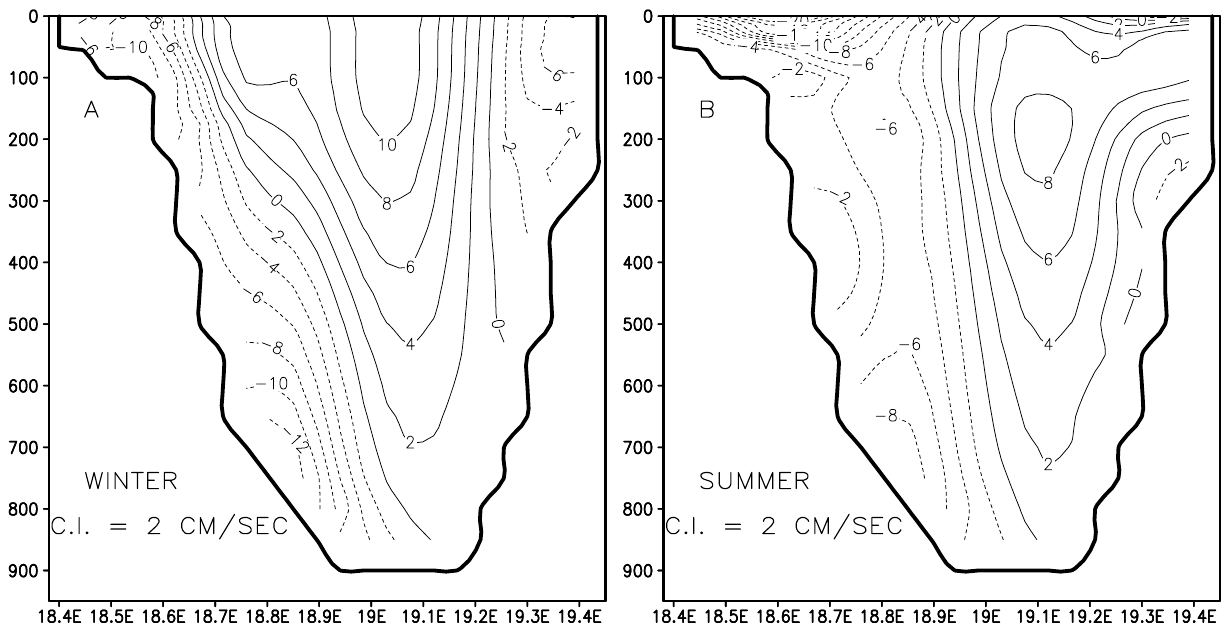
Fig. 13. Adriatic Intermediate Model (AIM). Seasonally averaged meridional velocity sections in the Strait of Otranto (zonal section B of Fig. 1). (A) : winter, (B) : summer. Contour interval is 1cm/s. Positive values denote northward flow. Seasons definition as in Artegiani et al. (1997a, b).